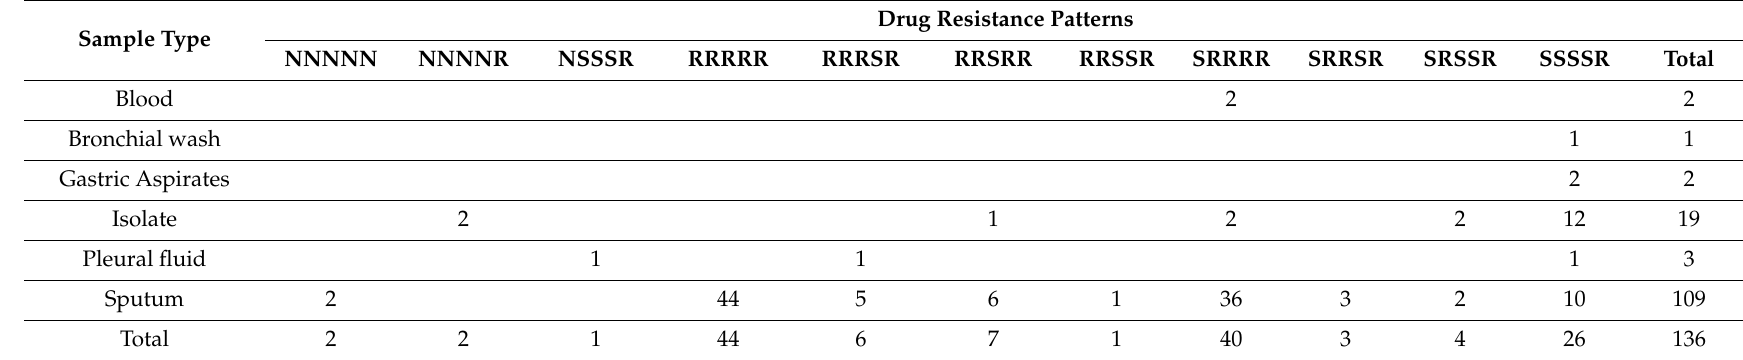
Table 3. Drug resistance patterns.